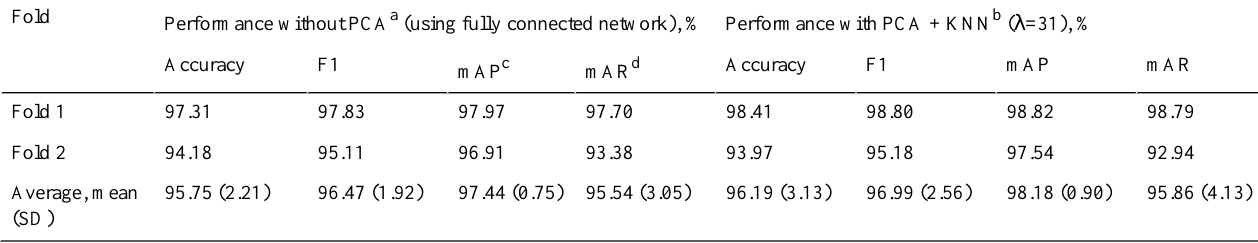
Table 1. Performance comparisons of our proposed network with and without applying the PCA.